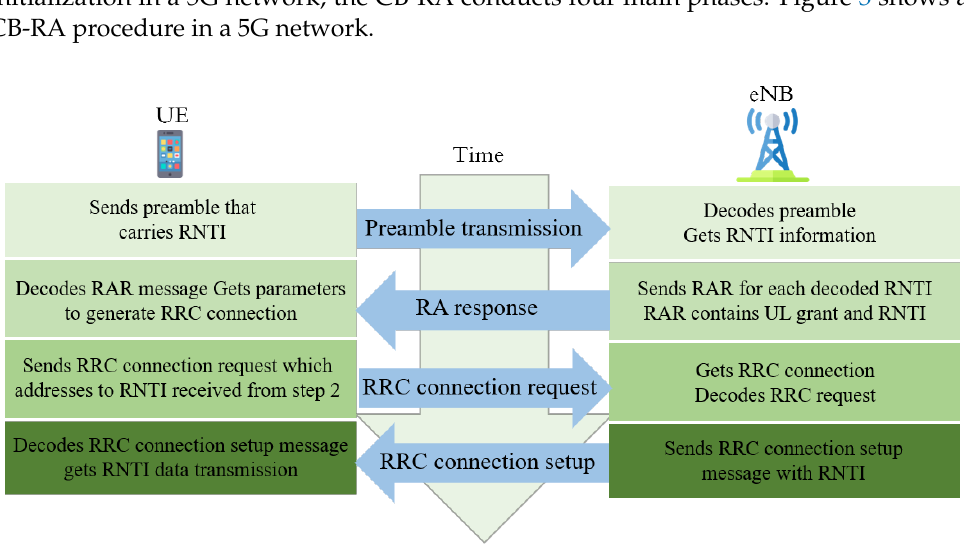
Figure 3. Contention-based random access (RA) procedure in a 5G